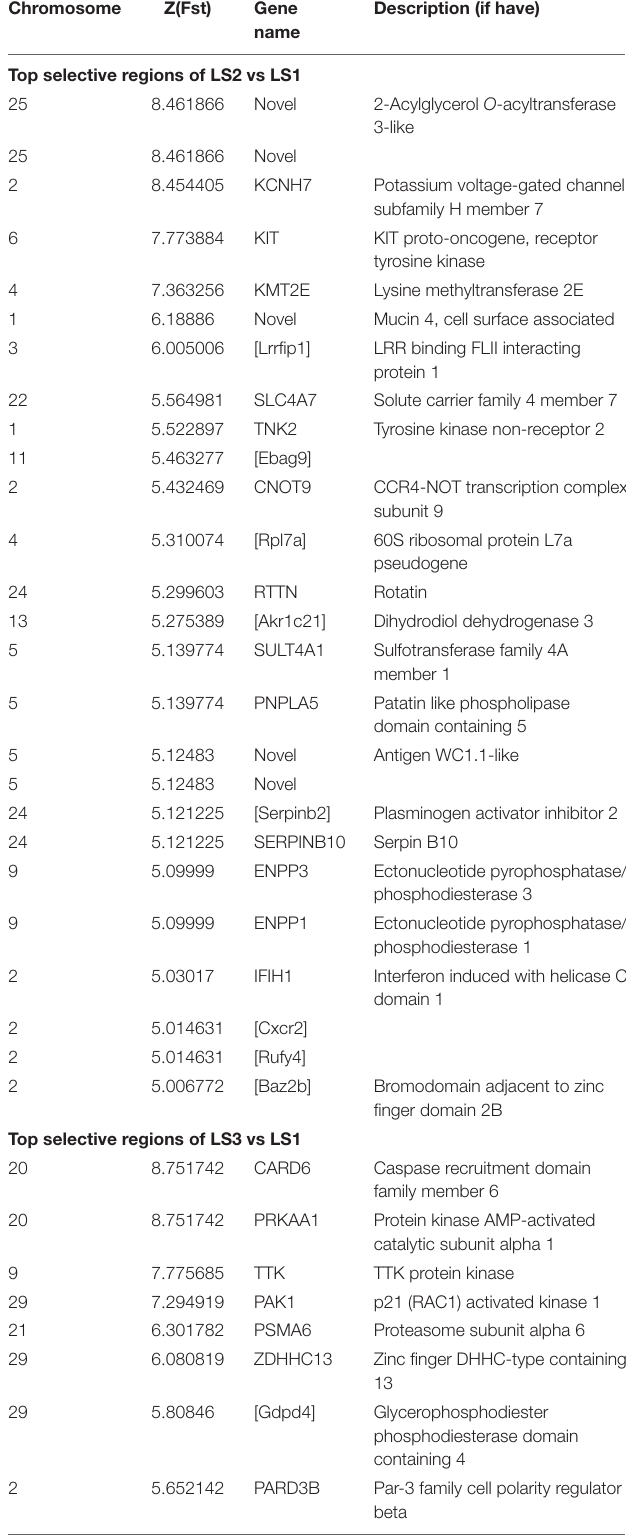
TABLE 2 | Gene located in selective regions of LS2 vs LS1 and LS3 vs LS1 with Z(Fst) > 5. Chromosome